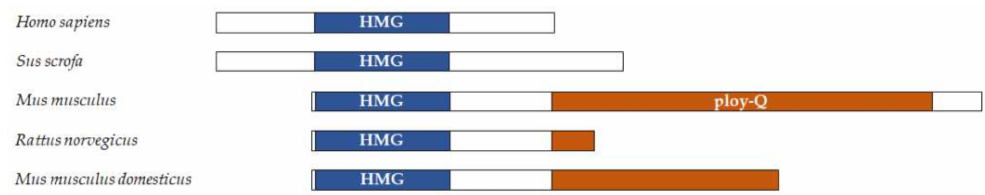
Figure 1. Comparison of structures of Sry protein from various mammalian species. Shown are the conserved HMG box (HMG) (in blue) and the polyglutamine (ploy-Q) region (in